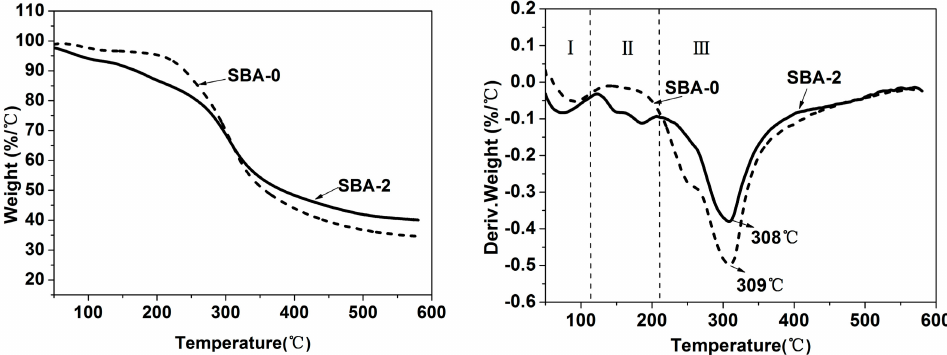
Figure 3. Thermogravimetric curves showing weight retention of SBA-0 and